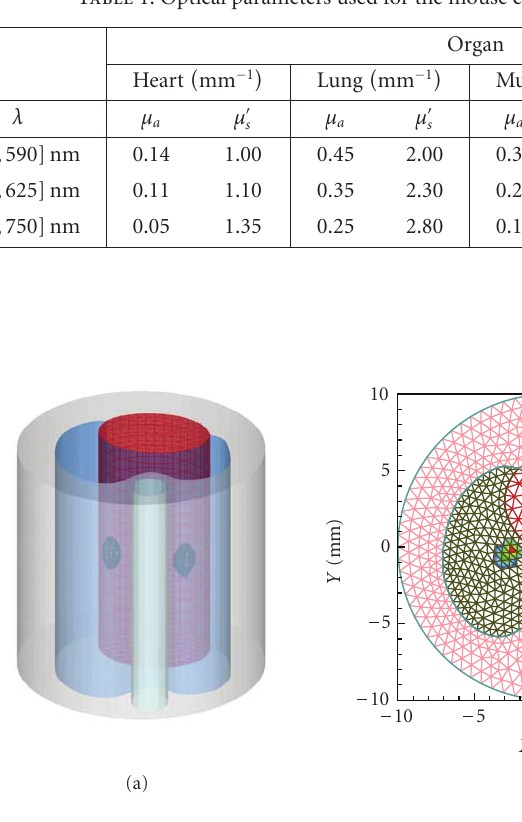
Figure 4: Bioluminescent source reconstruction from datasets collected using our proposed system. (a) A volume rendering of the 3D bioluminescent source reconstruction, and (b) a transverse section through the reconstructed